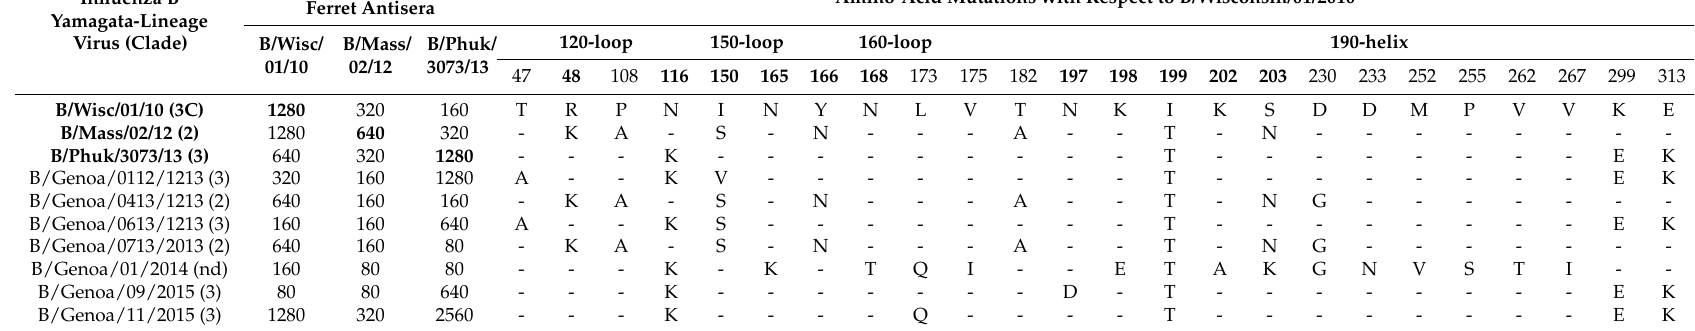
Table 3. Antigenic relationships between selected Ligurian Influenza B isolates and B/Wisconsin/01/2010, B/Massachusetts/02/2012 and B/Phuket/3073/2013 Yamagata-lineage reference viruses and the deduced amino-acid mutations found on the HA1 coding region with respect to B/Wisconsin/01/2010 (reference viruses, homologous titers and epitopes are in bold